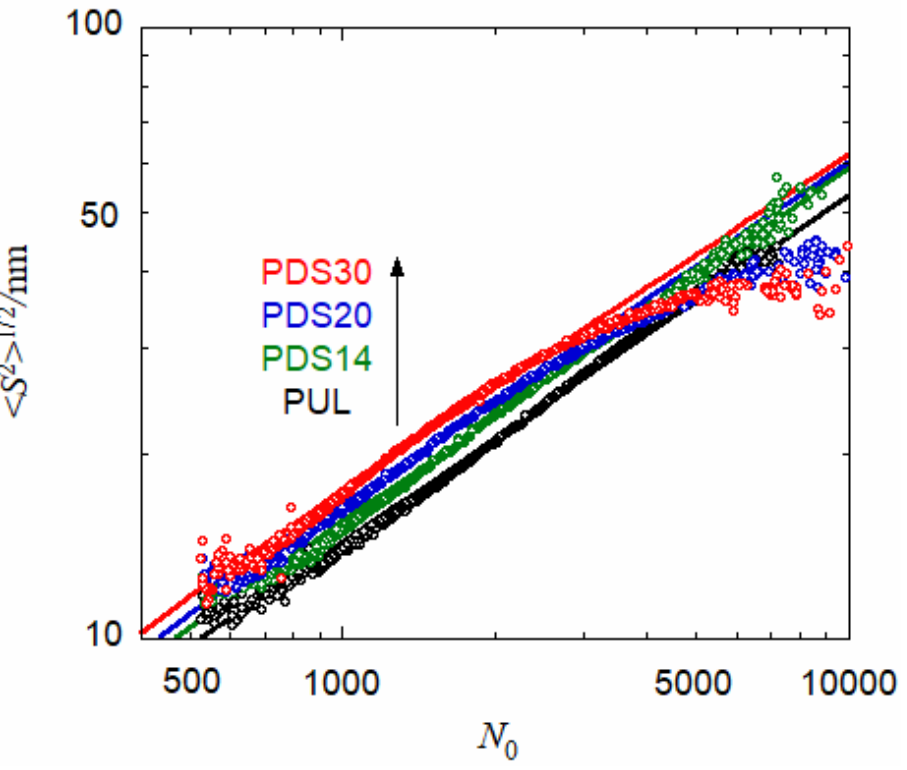
Figure 3. Degree of polymerization dependence of the radius of gyration (cid:104) S 2 (cid:105) 1/2 for PUL and PUL- OSA with three different DS in 0.01 M aqueous NaCl. Solid curves, calculated by Equation (11) with q = 1.4 nm (PUL), 1.57 (PDS14), 1.52 (PDS20), and 1.53 (PDS30) along with other parameters listed in Table 3.